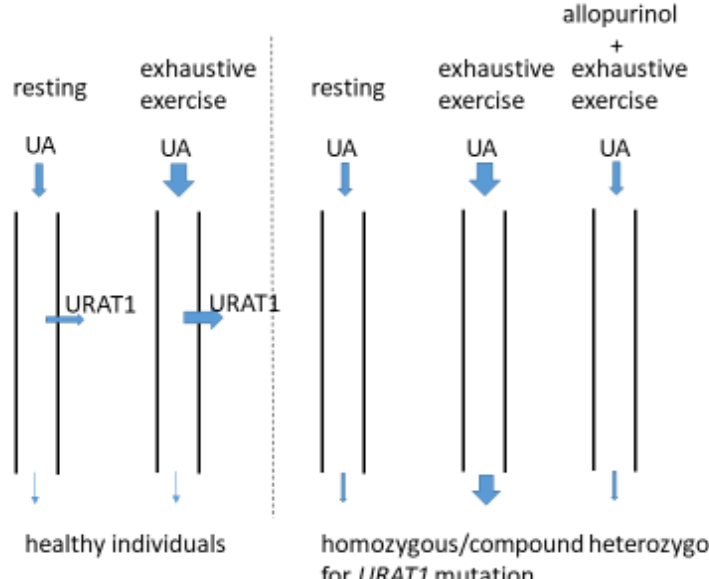
Figure 3. Increased UA load on renal tubules in individuals with homozygous/compound heterozy- gous URAT1 mutation after exhaustive exercise. A large amount of UA is produced by exhaustive exercise and then filtered through the glomeruli of the kidneys. In healthy individuals, an increased amount of filtered UA is reabsorbed by URAT1 and the amount of UA excreted into the urine does not increase [36]. On the other hand, in individuals with a homozygous/compound heterozygous URAT1 mutation, the filtered UA cannot be reabsorbed, resulting in increased excretion of UA in the urine [36]. In this case, it was suggested that the UA load on renal tubules increased after exhaustive exercise. Administration of allopurinol decreased the production of UA by exhaustive exercise and thus inhibited the increase of UA excretion in the urine [36]. EI-AKI did not develop after allopurinol administration [36]. A similar phenomenon will be observed in individuals with homozygous/compound heterozygous GLUT9 mutation.